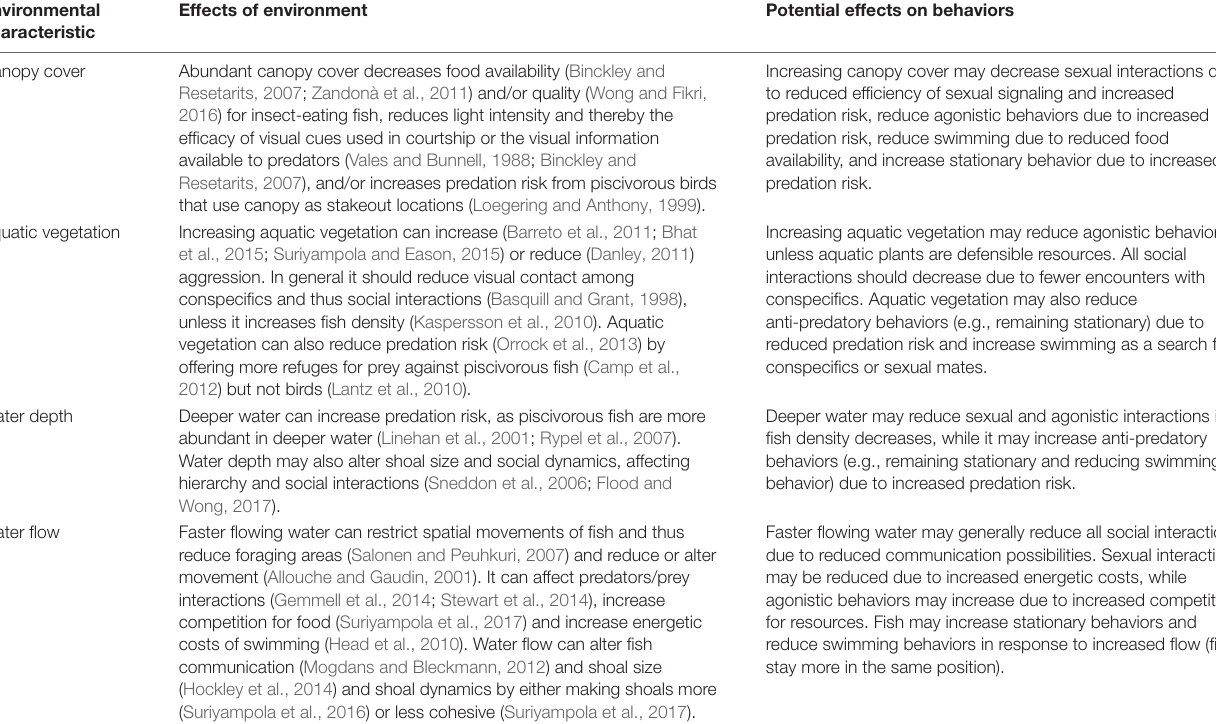
TABLE 1 | Summary of how environmental characteristics can typically influence socio-sexual and locomotor behaviors in fishes. Environmental